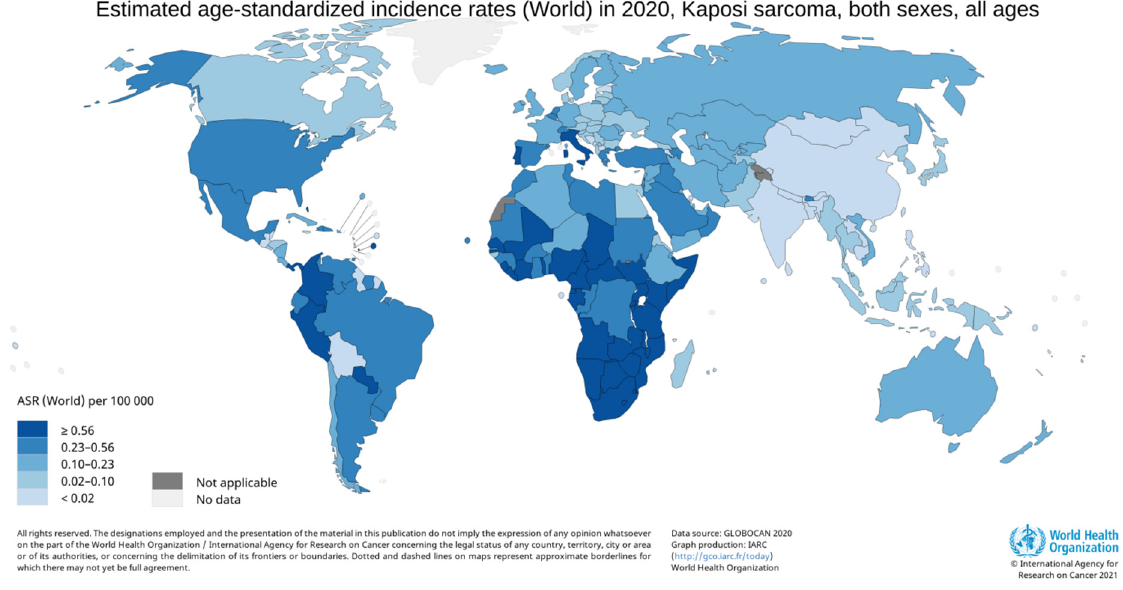
Figure 2. Incidence rates of Kaposi’s sarcoma in 2020. Data sources: Globocan 2020 (http://gco.iarc.fr/today, accessed on 29 June 2021).